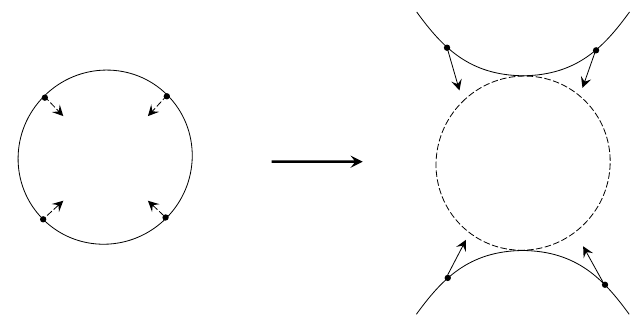
Figure 1. Analytic continuation of the boundary points. We start from a CFT on S d and analytically continue the insertion points of operators to complex values in order to recover the flat-space S-matrix. Geometrically this corresponds to going from a sphere to a